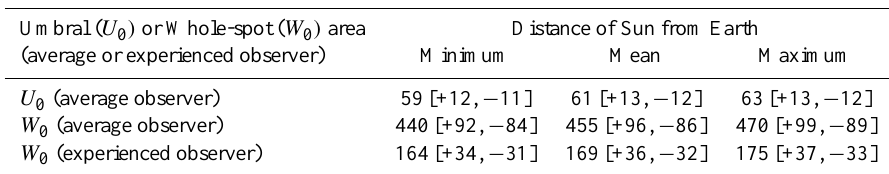
Table 1. The characteristic variation of the threshold sunspot areas during the course of the year is exemplified by presenting approximate numerical values of these projected areas for the minimum, mean and maximum distances of the Sun from the Earth. Numerical values of the projected umbral and whole-spot (umbral + penumbral) threshold areas, measured in millionths of the solar disk, are given for both “average” and “experienced” sunspot observers. For brevity, the symbols U 0 and W 0 (= U 0 + P 0 ) are used to denote the umbral and whole- spot threshold areas. The uncertainties associated with the threshold areas are based on characteristic uncertainties of ± 10% in the threshold sunspot dimensions (see Sects. 4 and 5 for further details); the first and second numbers in [square] parentheses correspond, respectively, to increases and decreases of 10% in the threshold sunspot dimensions quoted in arc seconds. These uncertainties are realistic illustrative “errors”, not absolute bounds on the